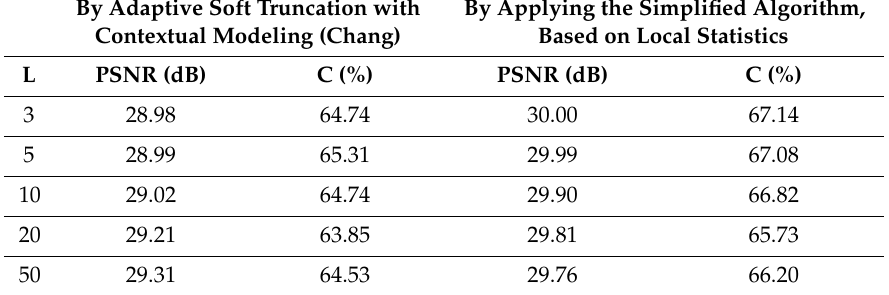
Table 2. Comparative results obtained by adaptive soft truncation with contextual modeling and applying the first two steps of our proposed method, in the case of processing only the details sub bands corresponding to the first scale of a wavelet transformation. The side of the analysis window is 2L + 1.